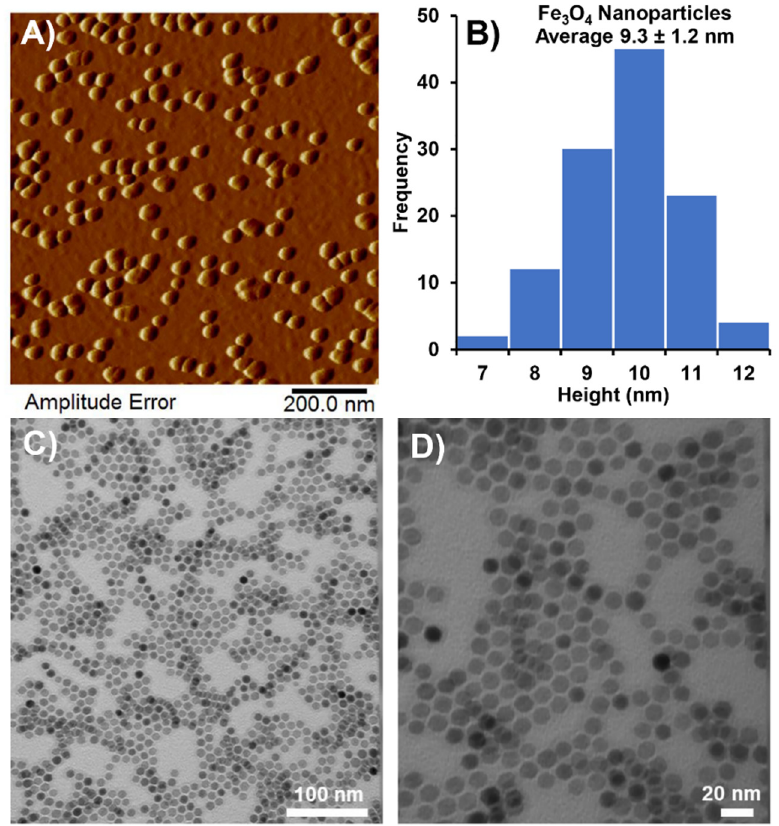
Figure 3. Characterization of synthesized Fe 3 O 4 nanoparticles. ( A ) AFM image of Fe 3 O 4 nanoparti- cles, ( B ) Fe 3 O 4 nanoparticle size distribution, ( C ) low-magnification TEM image of Fe 3 O 4 nanoparti- cles, and ( D ) high-magnification TEM image of Fe 3 O 4 nanoparticles.